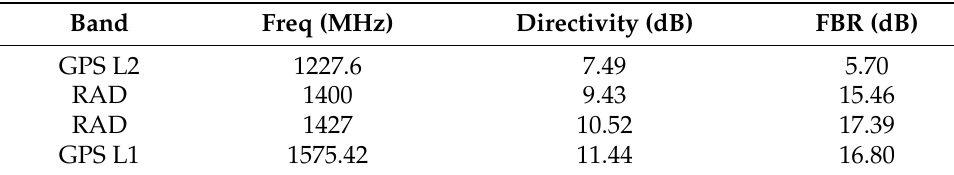
Table 10. CubeSat-sized ground plane measurements.